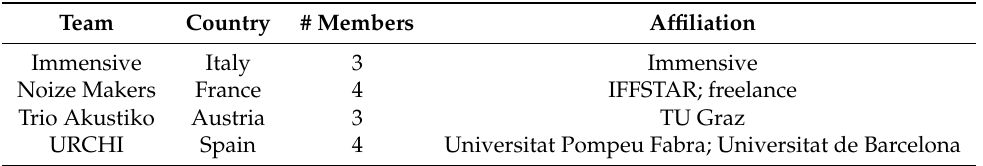
Table 1. The selected teams, their country, number of members and